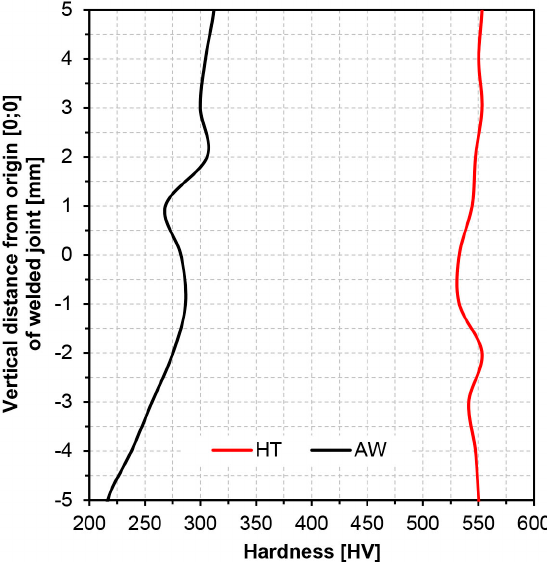
Figure 8. Hardness distribution of a Hardox Extreme welded joint along the line B shown in Figure 2. AW—condition after welding, HT—condition after heat treatment.